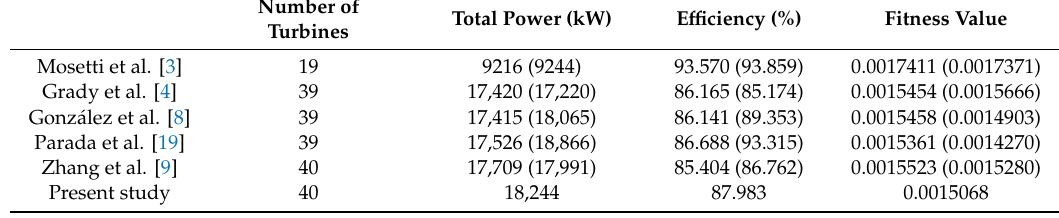
Figure 7. Layout results for case study (b).